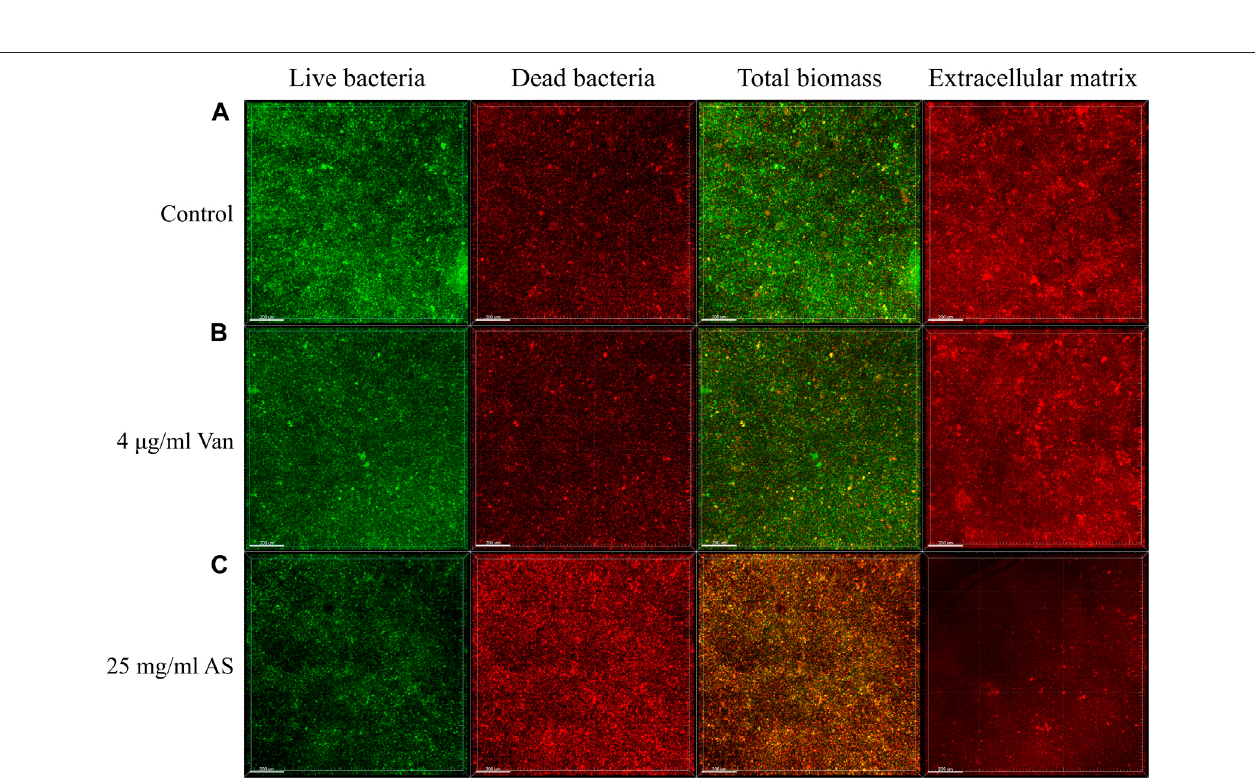
FIGURE2| CLSMmicrographsofMRSAbio fi lmstreatedwithASandVan.Inthe fi rstthreecolumns,greenrepresentsthe fl uorescencesignaloflivingbacteriaand red represents the fl uorescence signal of dead bacteria. The total biomass is the superposition of the two fl uorescence signals, which indicates the corresponding biomass distribution oflivingbacteriaanddead bacteria. Thefourthcolumn showsthedistributionoftheextracellularmatrix fl uorescence signal.Thescalebarinimages represents 200 μ